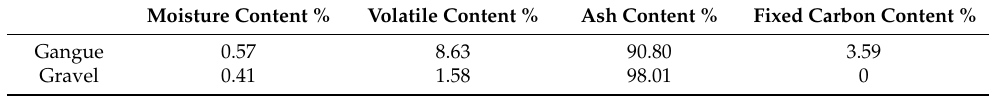
Table 7. Aggregate industry analysis.